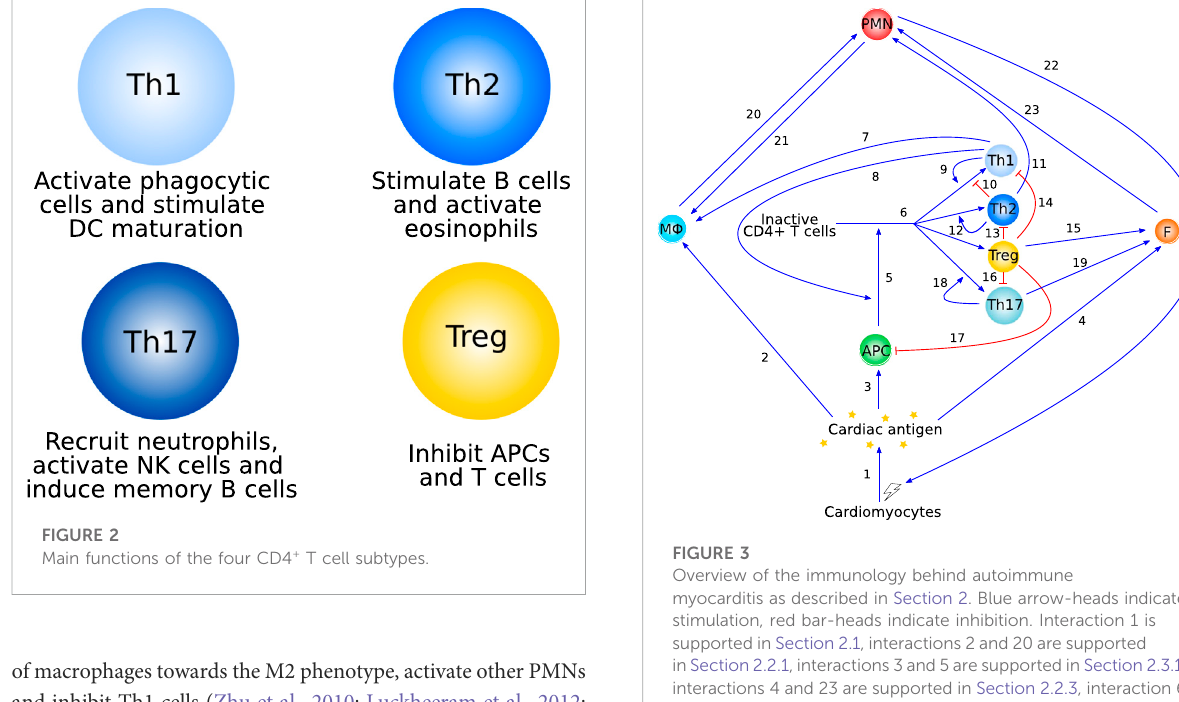
Overview of the immunology behind autoimmune myocarditis as described in Section 2. Blue arrow-heads indicate stimulation, red bar-heads indicate inhibition. Interaction 1 is supported in Section 2.1, interactions 2 and 20 are supported inSection 2.2.1,interactions 3and 5aresupportedin Section 2.3.1, interactions 4 and 23 are supported in Section 2.2.3, interaction 6 is supported in Sections 2.3.2.2 and 2.3.2.4, interactions 7 – 17